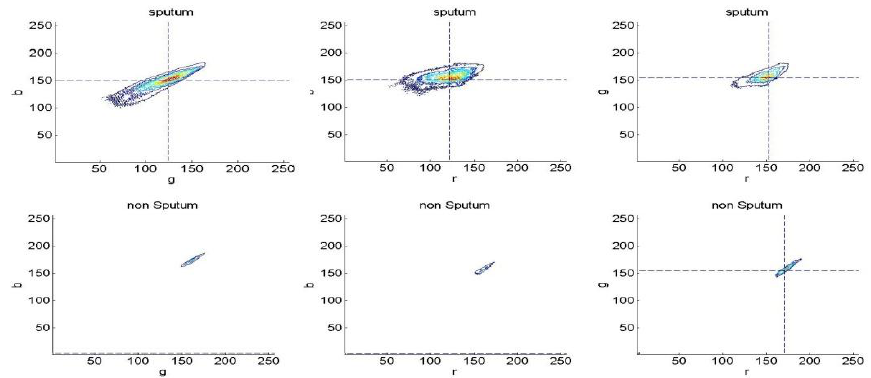
Figure 3. 256- RGB color space Histogram visualization for the sputum and non-sputum pixels.